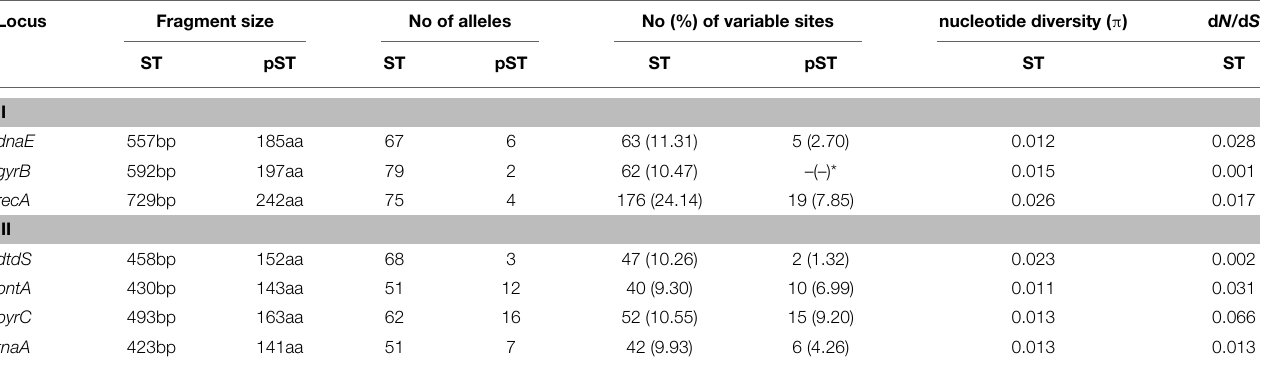
TABLE 1 | Diversities of the seven loci in the 218 V. parahaemolyticus isolates. Locus